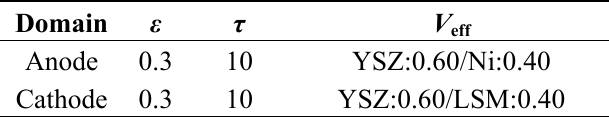
Table 2. Properties for the porous